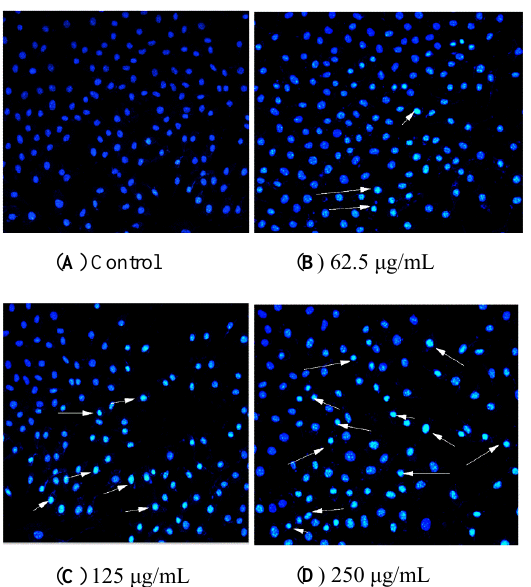
of the apoptotic population in HCT116 cells treated with BSO at 125 and 250 µ g/mL for 36 h were 10.4% and 21%, respectively (Figure 5). These results confirmed that BSO could induce significant apoptosis of HCT116 cells.